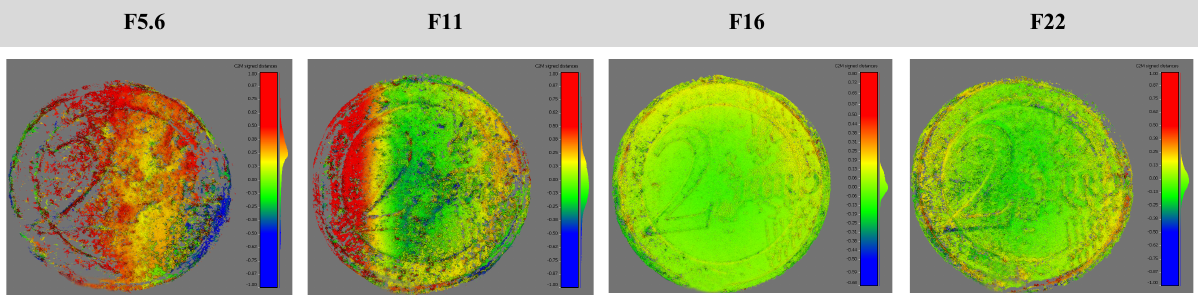
Figure 5. Cloud-to-Mesh comparison [mm] with F5.6, F11, F16 and F22 for the 2-euro case study. Range [-1/1